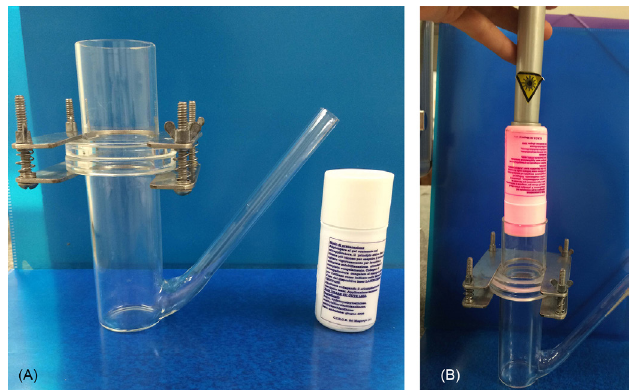
FIGURE 1 - ( A ) Adapted Franz cell and the package where the gel was frozen; ( B ) Simulation of the laser attached to the package that contains diclofenac sodium frozen